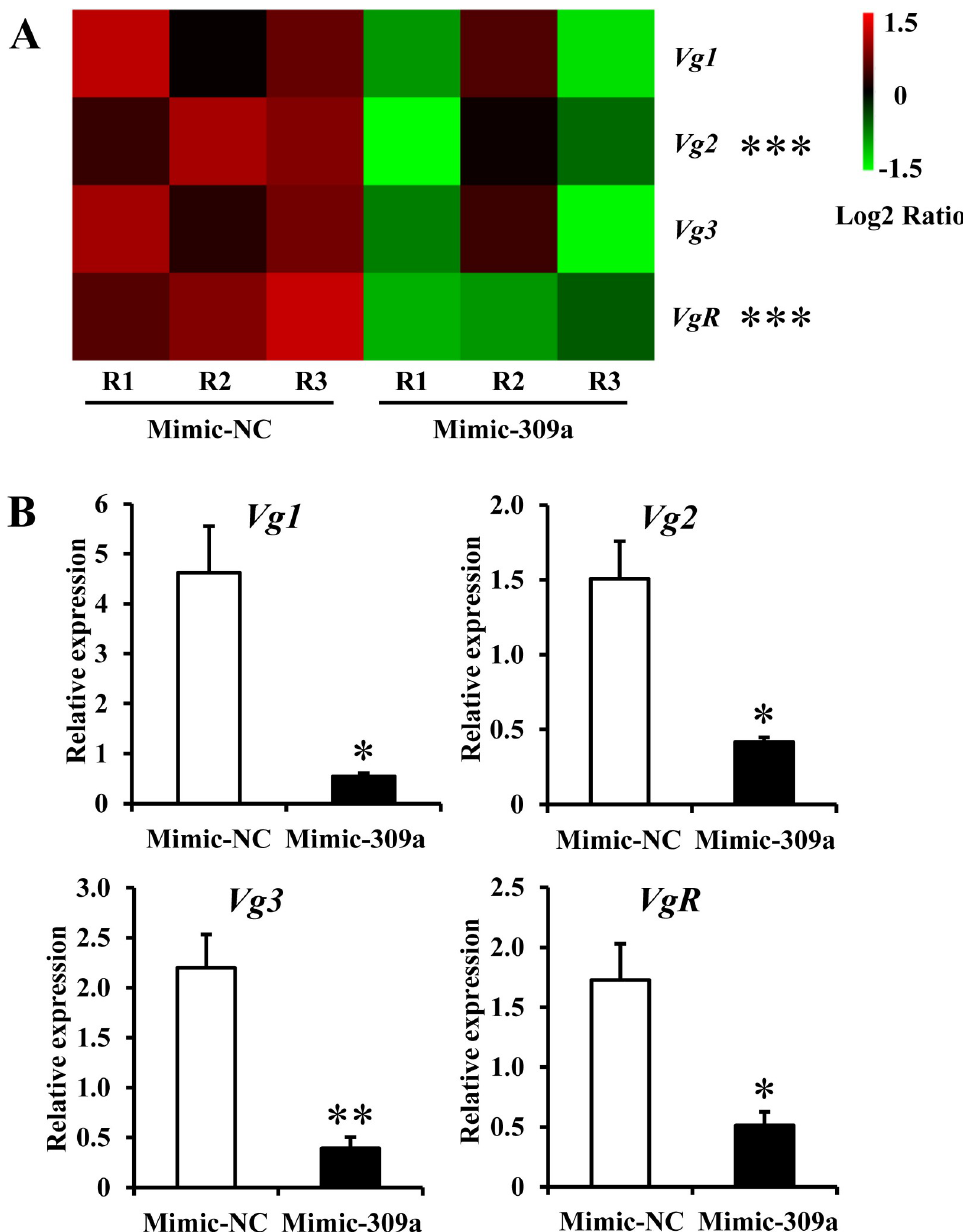
Fig 5. Relative expression of Vg- related genes ( Vg1 , Vg2 , Vg3 , and VgR ) after mimic-309a injection. (A) Illumina sequencing results. For the significance test: unmarked � indicates not significant; ��� false discovery rate (FDR, an adjusted P -value) < 0.001 with log 2 |Fold change| > 2. R1, R2, and R3 indicate three independent biological replications. The color code indicates the fold change of the gene abundance in the form of a logarithm. The fragments per kilobase of exon per million fragments mapped (FPKM) of genes is normalized in each row. (B) qPCR results. a-tubulin and rps3 as reference genes were used to normalize the expression of Vg- related genes. The differences between means were analyzed by Student’s t test. For the significance test: � P < 0.05; �� P < 0.01. Data are means ± SE (error bars) of four biological